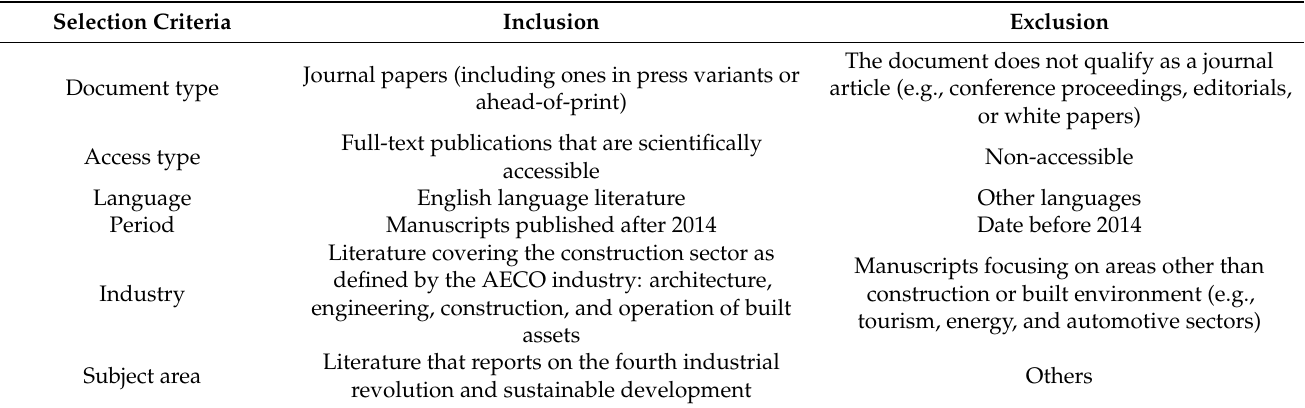
Table 4. Inclusion and exclusion criteria for literature.